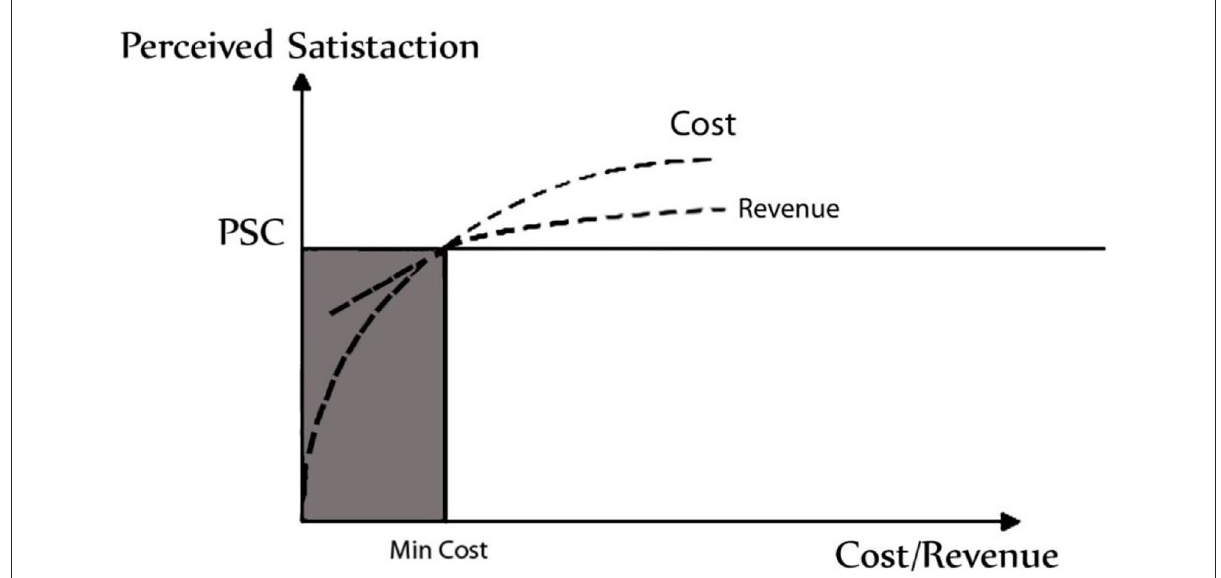
FIGURE8 For an unprofitable section of clients, the link between perceived pleasure, expenses, and revenues.